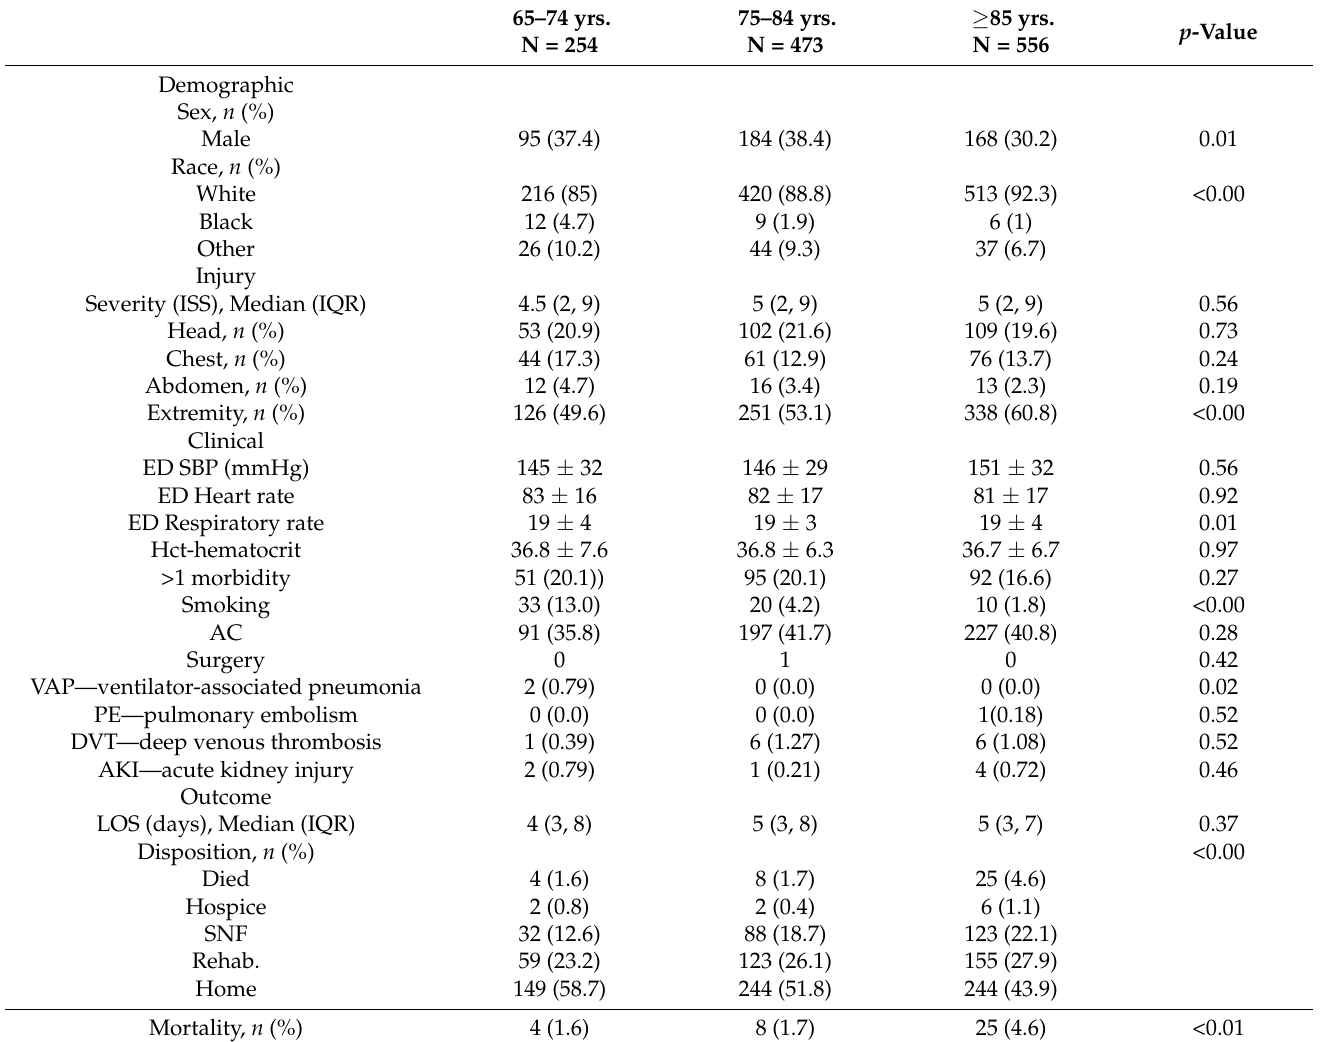
Table 2. Demographic, injury, clinical characteristics and outcomes of geriatric trauma patients with low-energy blunt trauma divided into three age groups. 65–74 yrs. 75–84